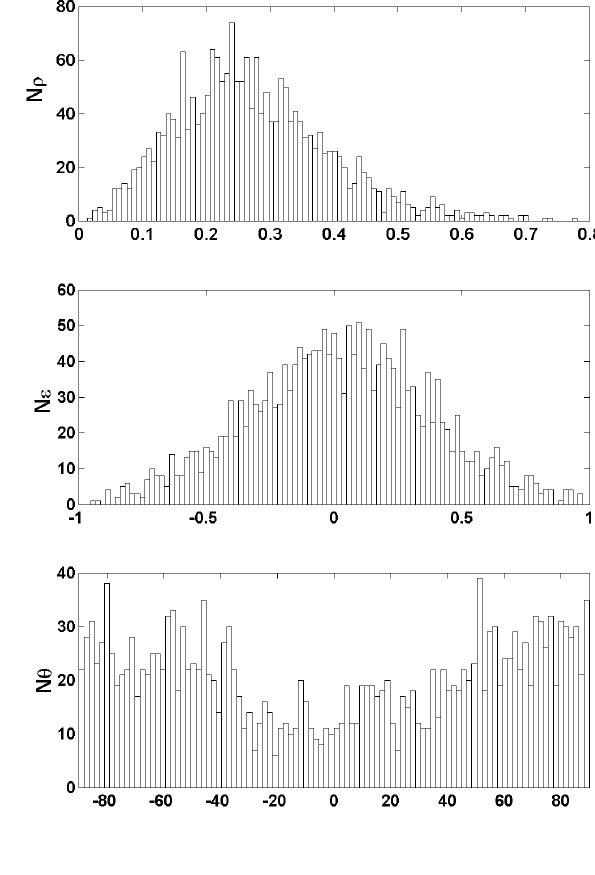
Figure 13. Distribution of the polarization